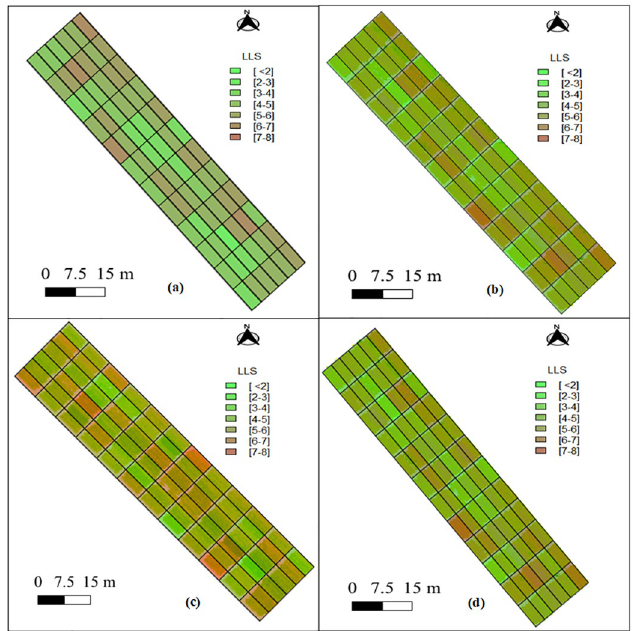
Fig 14. The visual mapping of late leaf spot (LLS) in a peanut field of 72 plots a) actual LLS score, and LLS score estimated with b) MI-based method (using REVI) c) CV-based method (using SR), e) mean-based method (using